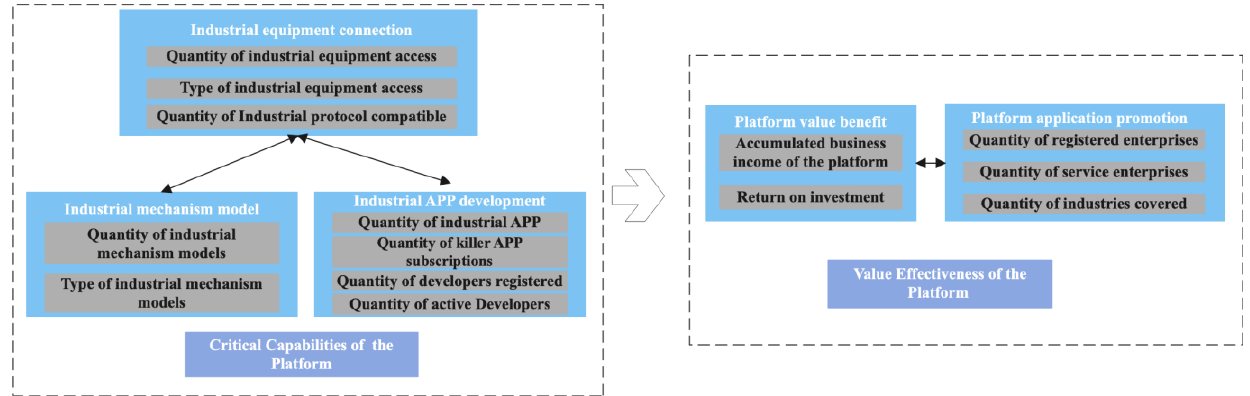
Figure 1. Monitoring target system of the development index of Industrial Internet Platform.